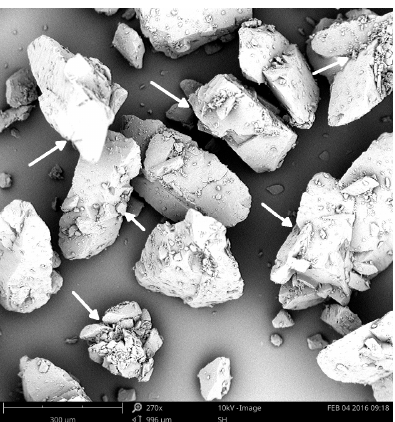
Figure 8. Final crystal morphology of the API after conventional seeded crystallization protocol followed by 60 min sonication at 15 W. SEM images are magnified 270 times and the scale bar represents a length of 300 µm. The white arrows indicate the remaining presence of agglomerates.